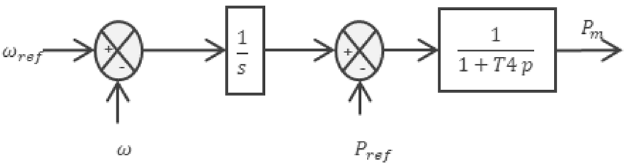
Fig. 4. Simpli fi cation of thermal or nuclear regulation.